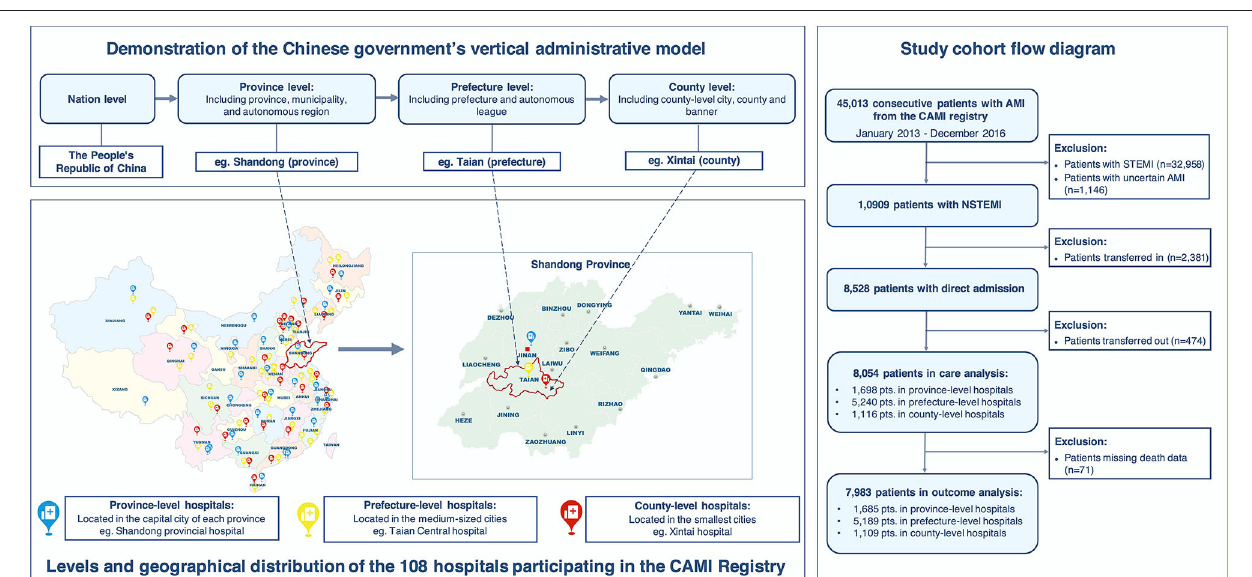
FIGURE 1 | Demonstration of the levels and geographical distribution of the hospitals participating in the CAMI Registry and study cohort flow diagram. The Chinese public hospital system follows a three-level structure based on the Chinese government’s vertical administrative model: province-level hospitals (located in the capital cities of each province, Blue marker), prefecture-level hospitals (located in the medium-sized cities, Yellow marker), and county-level hospitals (located in the smallest cities, Red marker), in the order of decreasing scale and level. The CAMI Registry included 108 hospitals covering the three hospital levels from 31 provinces and municipalities throughout Mainland